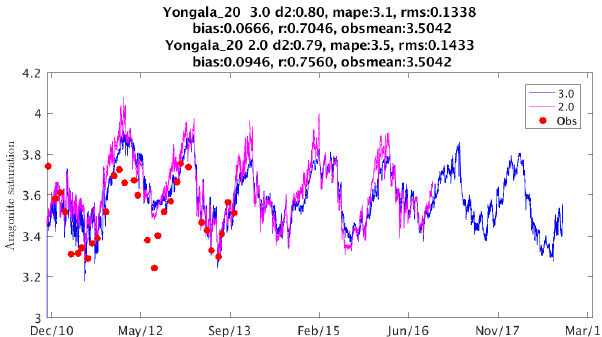
Figure 18. Aragonite saturation state calculated from temperature, DIC and alkalinity at 20m depth at the Integrated Marine Observing System (IMOS) Yongala mooring, central GBR: observations (red dots), simulations B2p0 (pink) and B3p0